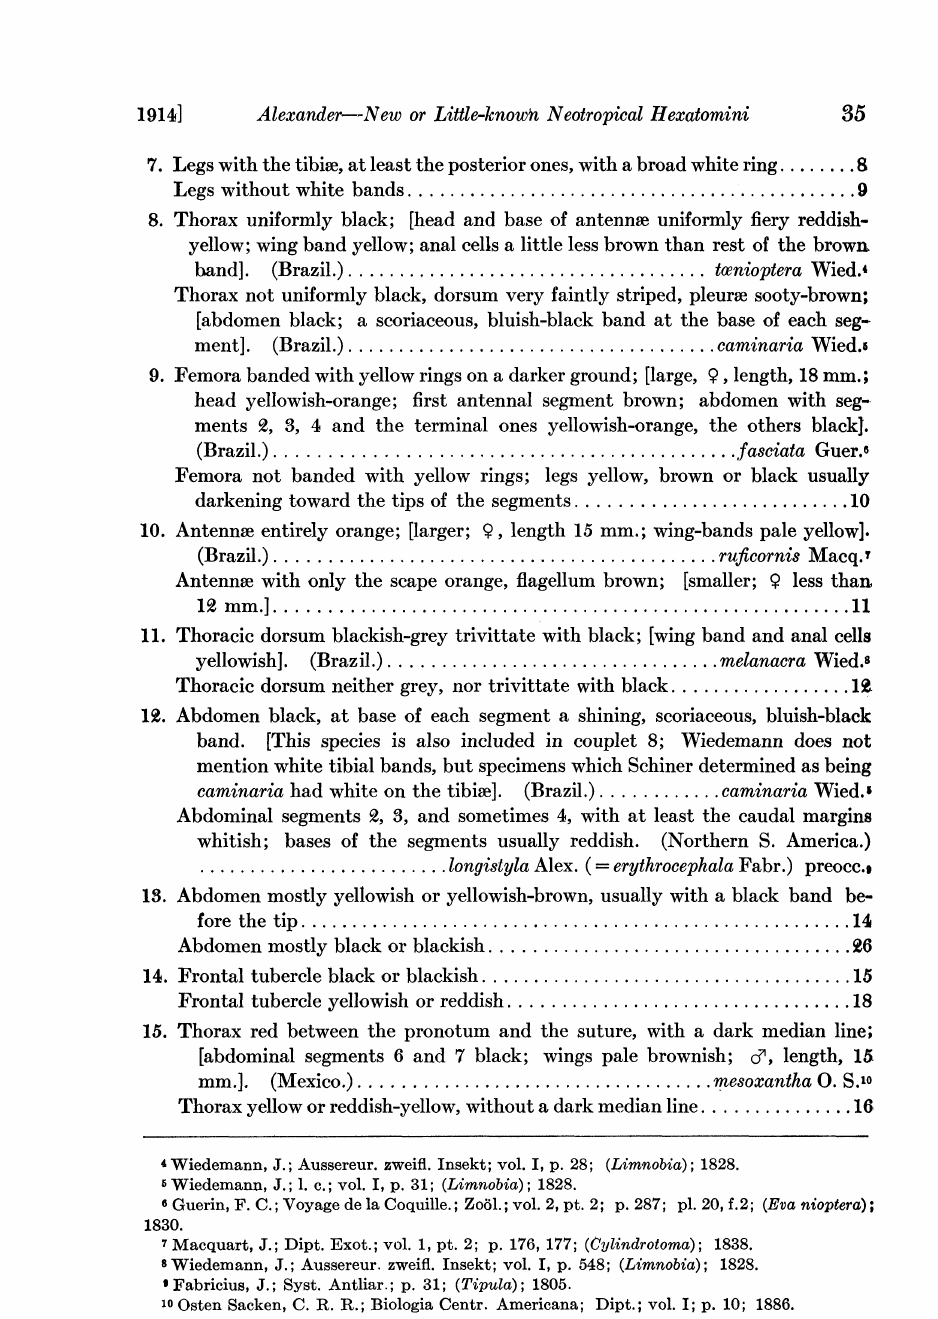
yellowish]. (Brazil.) Thoracic dorsum neither grey, nor trivittate with black lg li. Abdomen black, at base of each segment a shining, scoriaceous, bluish-black band. [This species is also included in couplet 8; Wiedemann does not mention white tibial bands, but specimens which Schiner determined as being caminaria had white on the tibim].